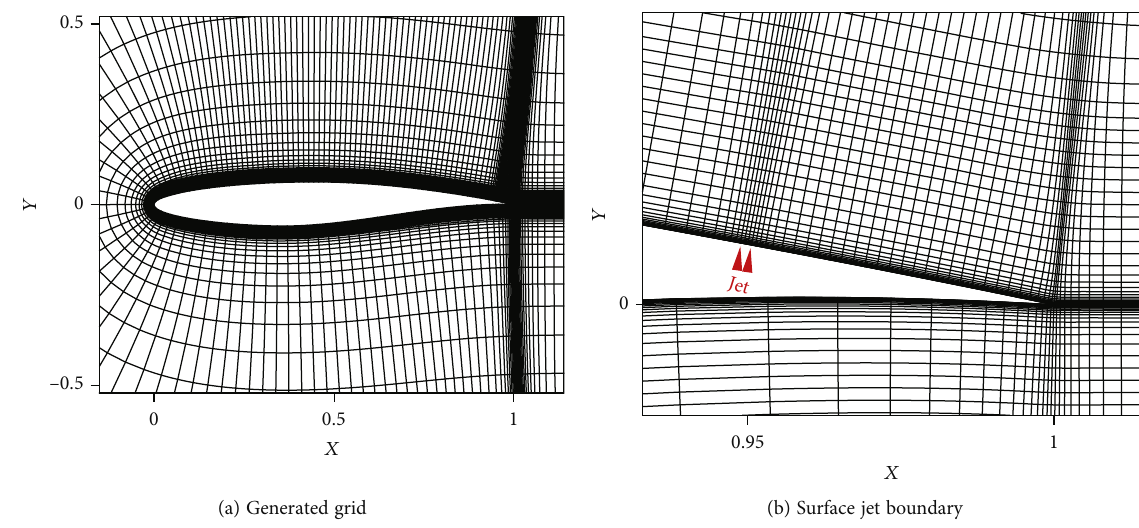
Figure 3: The computational grid around RAE2822 airfoil with a normal jet on the suction surface (every 4